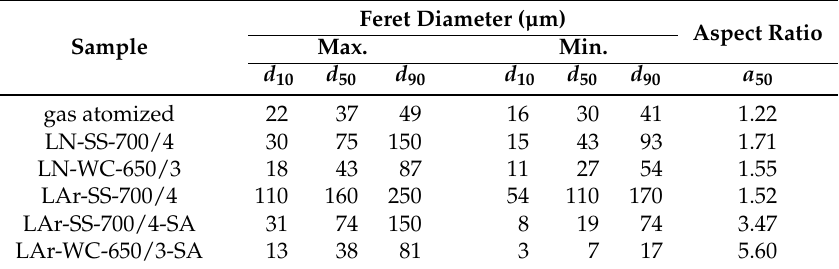
Table 2. Particle size and shape characteristics. The median d 50 , 10th and 90th percentile d 10 and d 90 of Feret diameter and the median of aspect ratio a 50 are given for each sample. Feret Diameter (µm) Aspect Ratio Sample